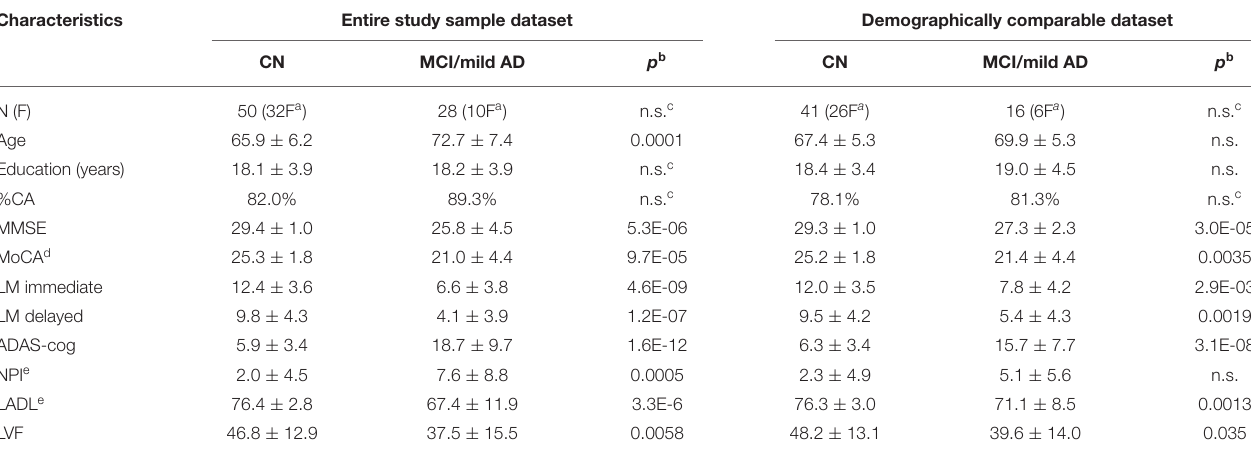
TABLE 1 | The demographics and neuropsychological test scores of CN and MCI/mild AD participants.